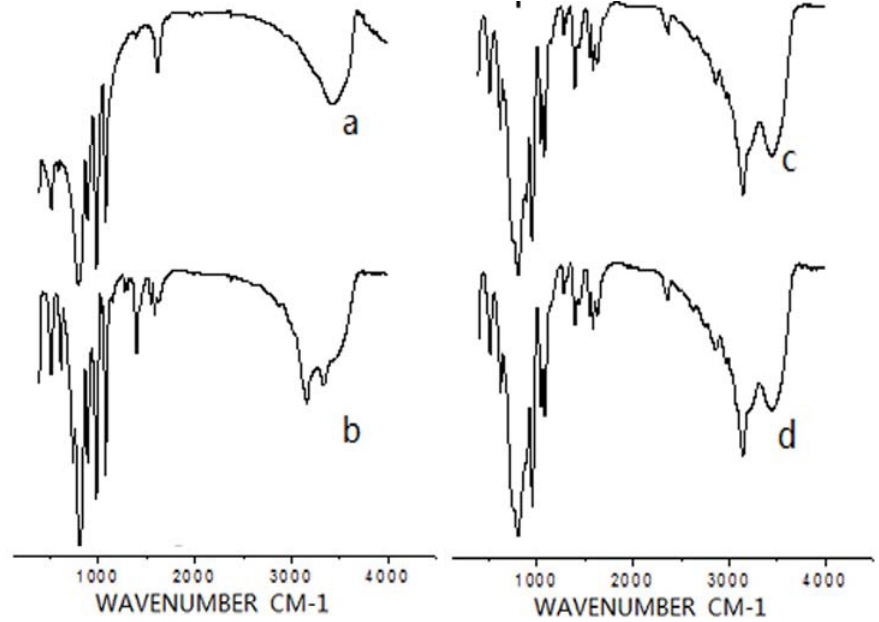
Figure 1. IR analysis. ( a ) phosphotungstic acid; ( b ) N -methyl imidazolium